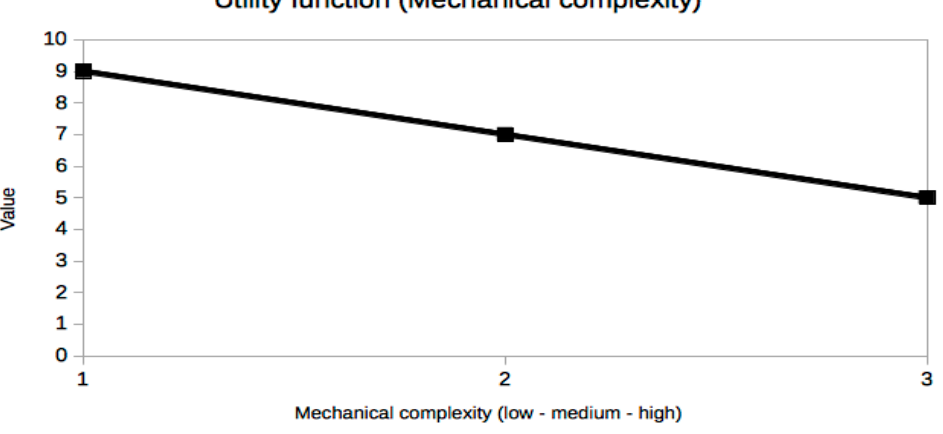
Figure 9. Utility function for Mechanical complexity.